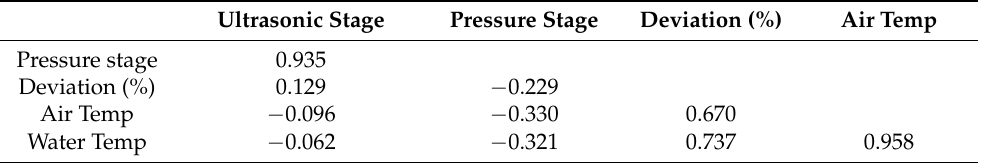
Table 2. Pearson correlation coefficients ( r ) between water stages measured by the ultrasonic and the pressure transducer sensors, air temperature and water temperature based on the entire data